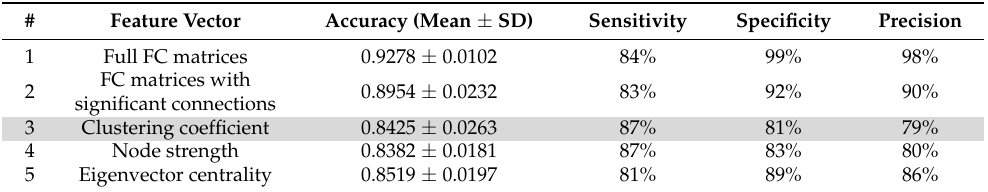
Table 6. Classification accuracy of different connectivity features.